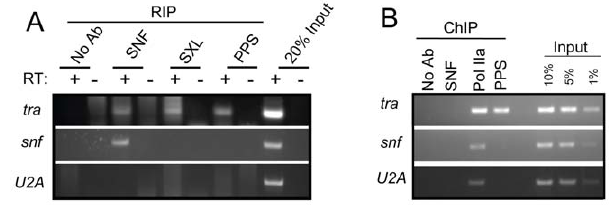
Figure 8. tra is a PPS target gene. (A) RIP assays demonstrating that PPS associates with the tra pre-mRNA, but not the snf pre–mRNA or the intronless U2A transcript. The presence of unspliced RNA in the IP pellet was detected by RT–PCR. (B) ChIP assays demonstrating that PPS is detected at the tra promoter (identified by Pol IIa accumulation), but not at the snf or the U2A promoter. The exact position of the primers used in the RIP and ChIP assays are described in the Materials and Methods